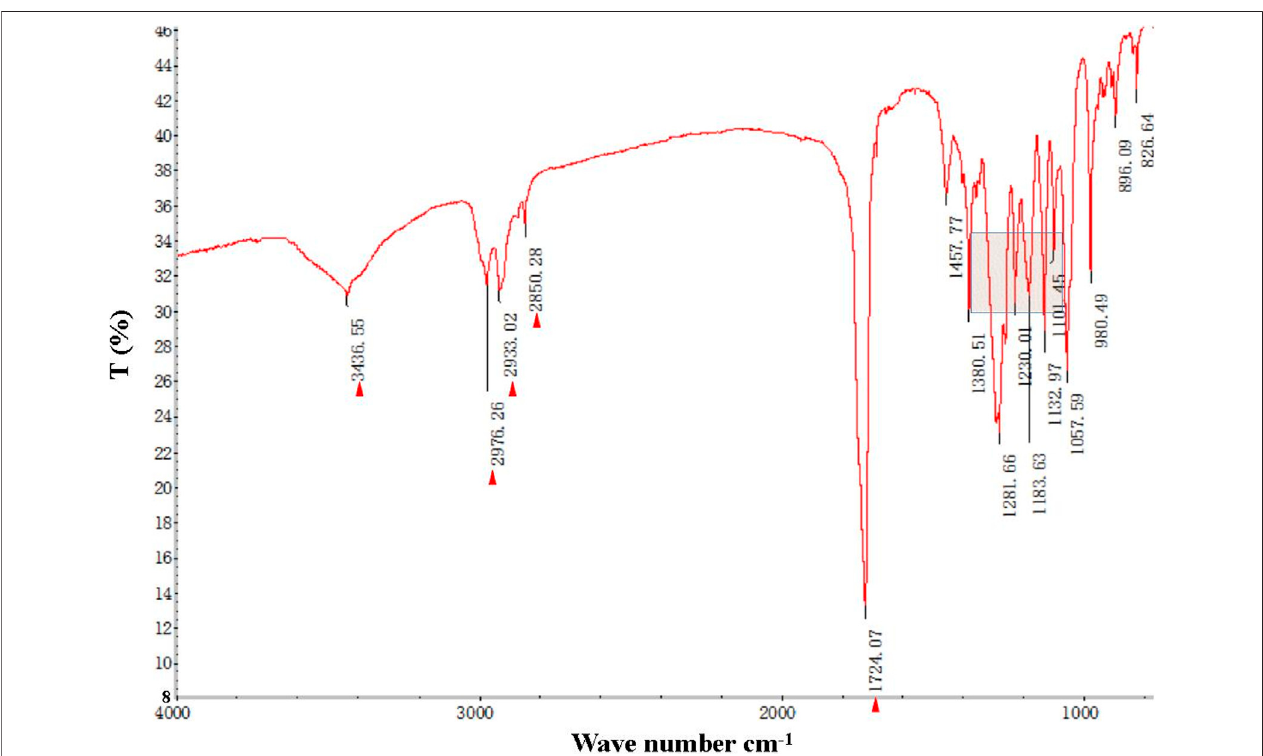
FIGURE 2 | Fourier transform infrared (FT-IR) spectra of PHB extract from SS. Red triangle and box with blue line mean bands of